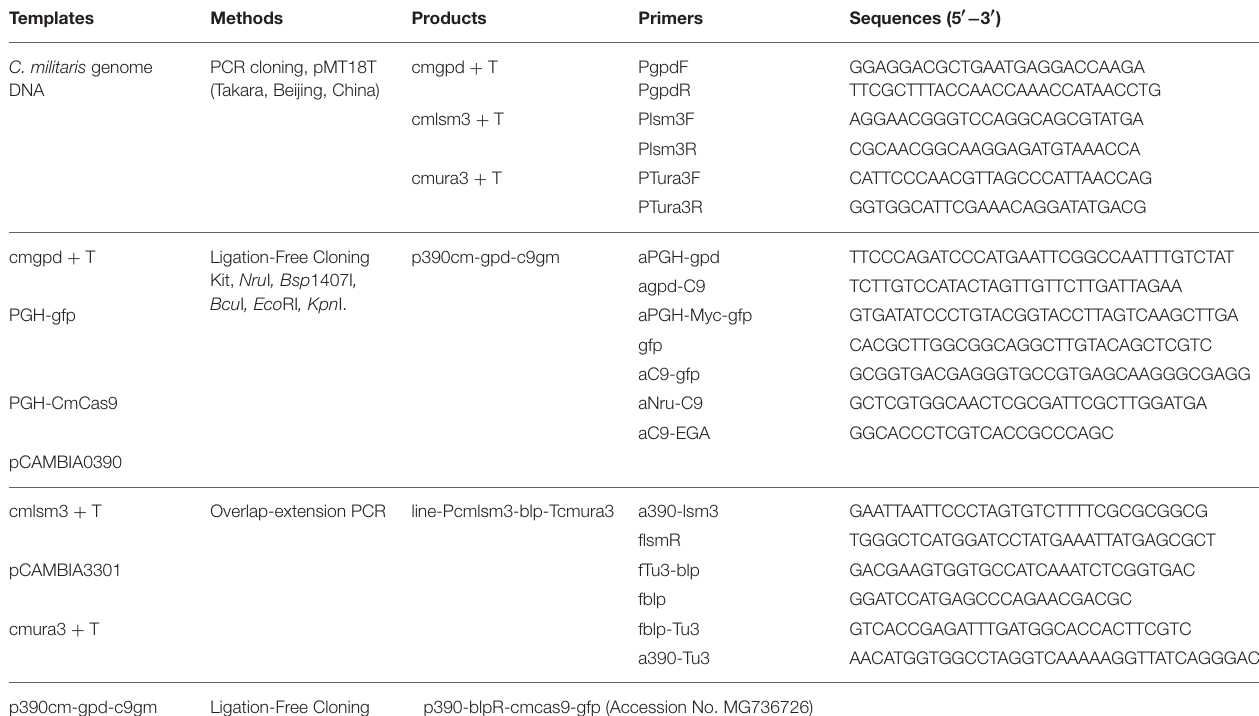
TABLE 2 | Methods and primers for vectors construction.